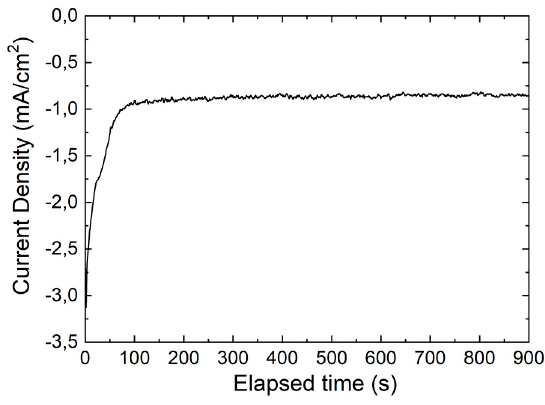
Figure 5. CZTSe film growth curve. The deposition was carried out applying a potential of − 0.65 V (SCE) for 15 min.